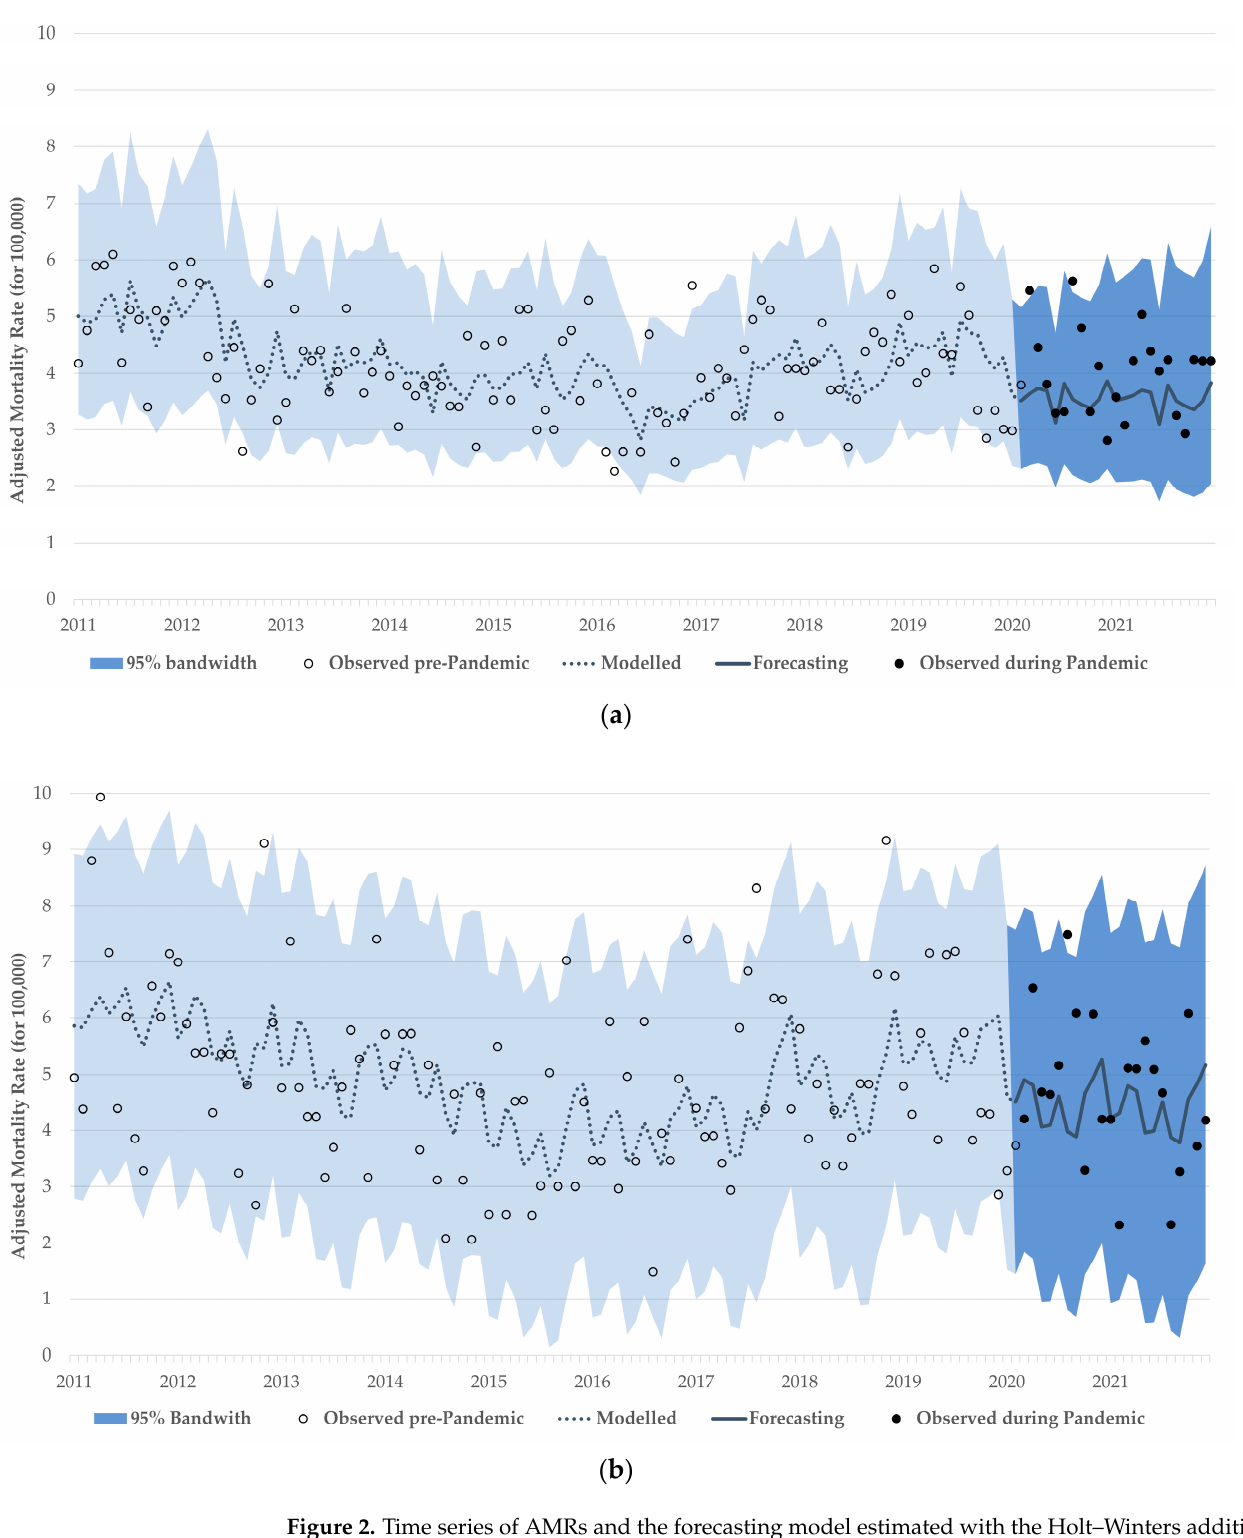
Figure 2. Time series of AMRs and the forecasting model estimated with the Holt–Winters additive method: ( a ) province of Taranto and ( b ) municipality of Taranto.